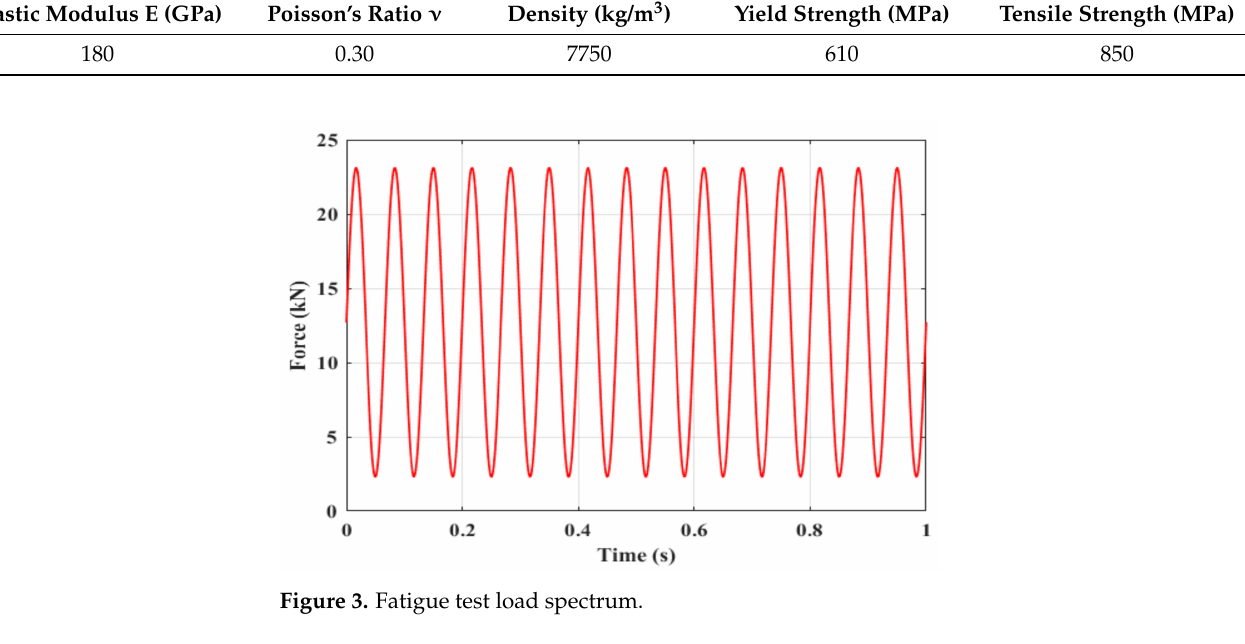
Figure 3. Fatigue test load spectrum.